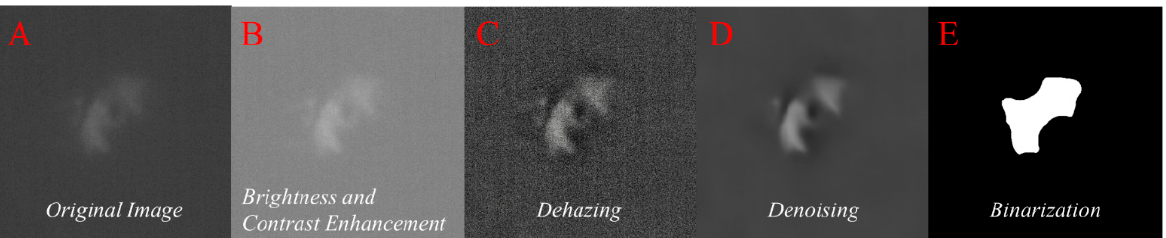
Figure 8. Step-by-step results (from B – E ) of the image analysis carried out with PA on the original image ( A ).